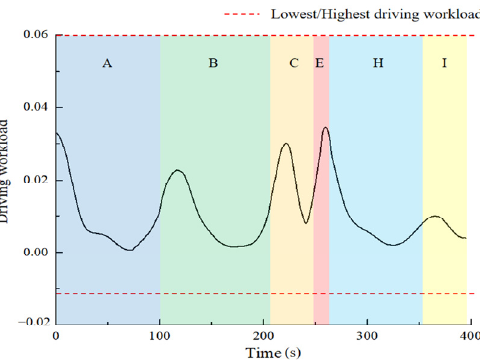
Figure 9. Change trend of driving workload in different areas of the work zone. Table 6. Results of driving workload statistics for different areas and vehicles.